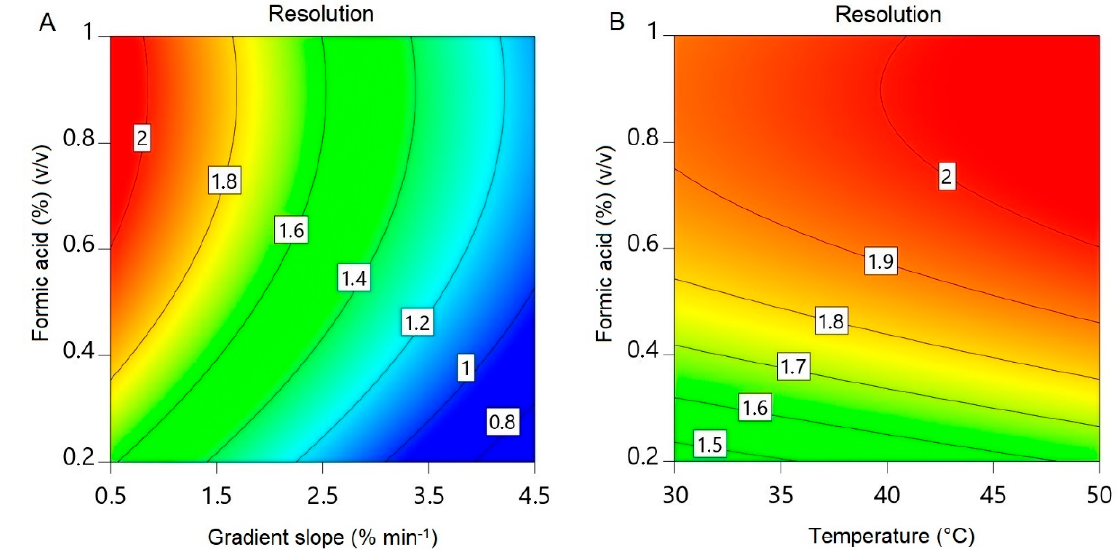
Figure 7. Contour plots of the reduced quadratic resolution model. ( A ) Formic acid concentration and gradient slope at 50 °C. ( B ) Formic acid concentration and temperature at a gradient slope of 0.5% min − 1 .